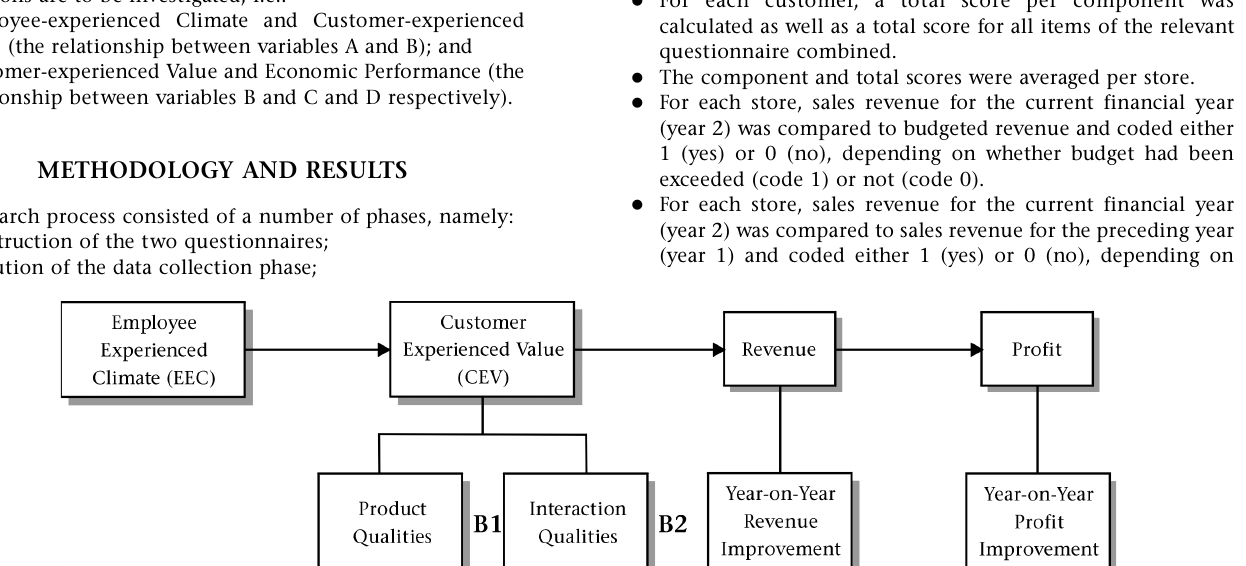
Figure 3: Research